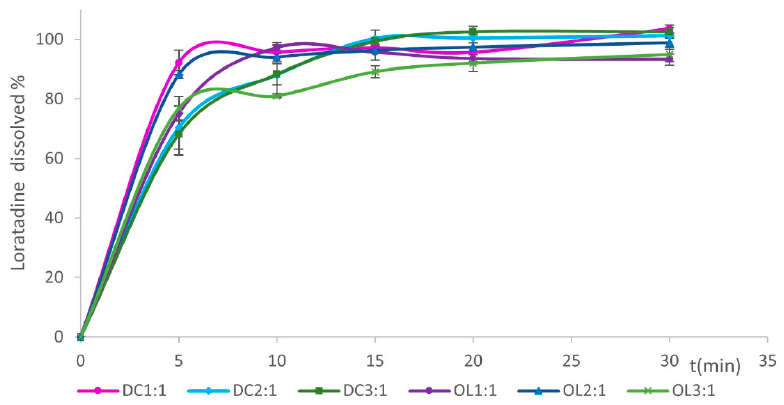
Figure 6. Dissolution curves of ODx.